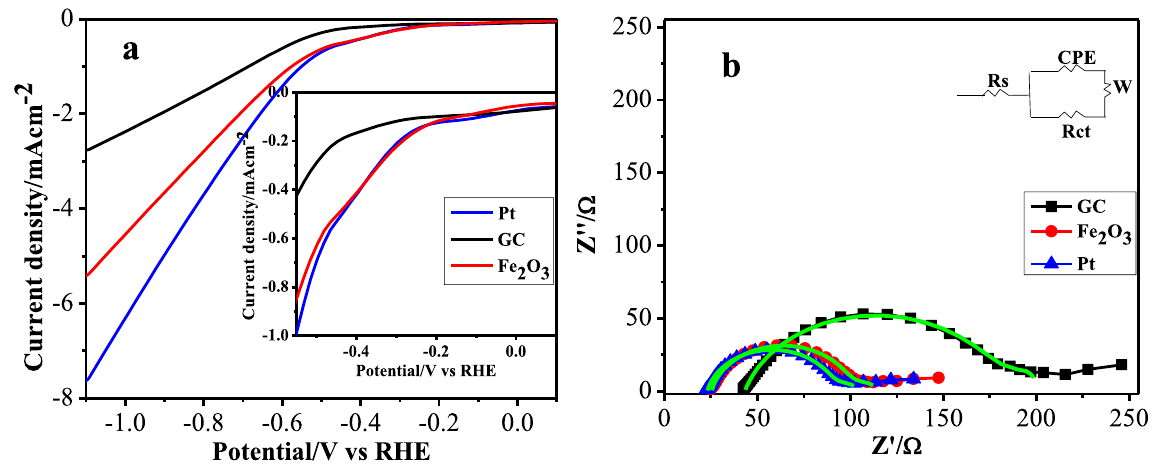
50 mV s −1 scan rate, and b EIS spectra at − 0.6 V vs RHE, green lines Fig. 3 The influence of different counter electrodes on the elec- troreduction of CO are fitted spectra and the inset is the equivalent electric circuit to CO using Au film (150 nm) as a cathode; a 2 LSV curves measured in CO -saturated 0.1 M KHCO electrolyte at 2 3